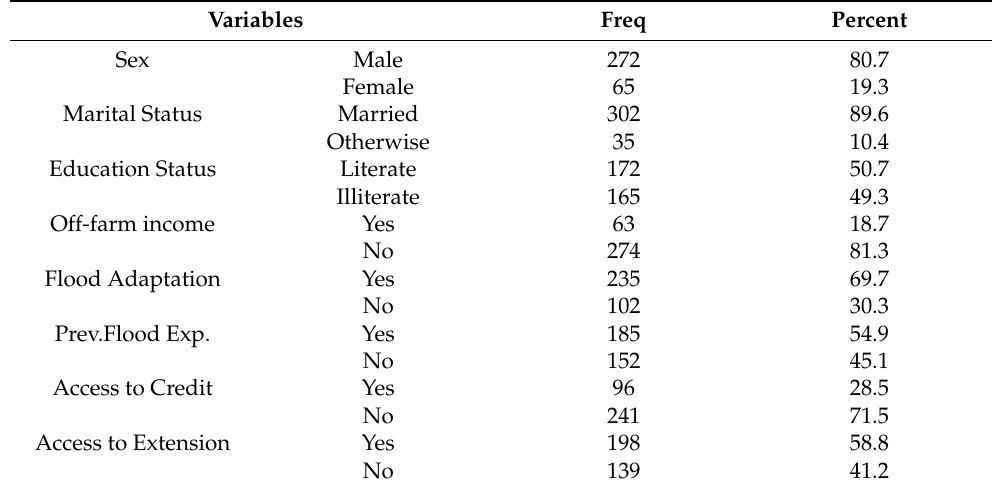
Table 3. Basic Descriptive Analysis of Dummy